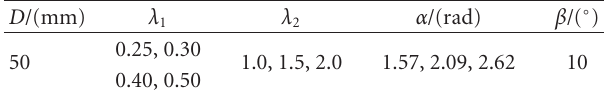
Table 1: Structural Parameters of Venturi injector.